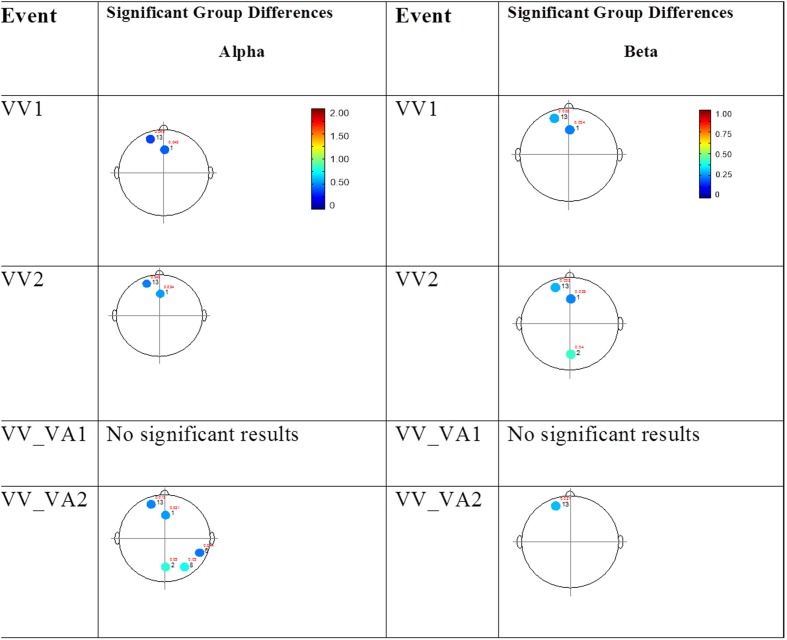
Session 2 alpha and beta EEG power group differences-unimodal visual presentations. Results for the alpha band (left) and beta band (right) are presented. Significant differences were determined using the Tukey–Kramer method for p < 0.05.